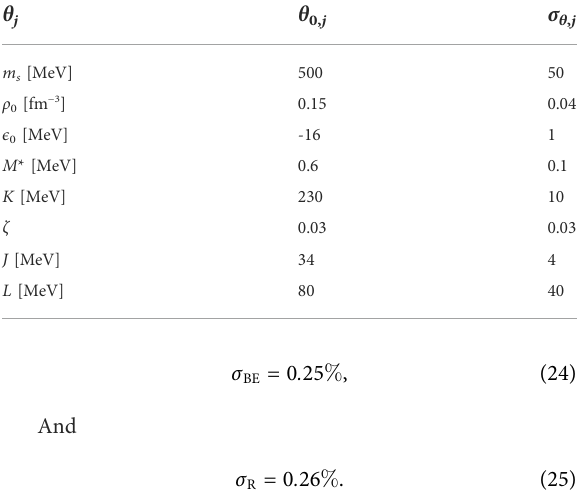
TABLE 2 Prior central values and standard deviations for the eight model parameters used in the